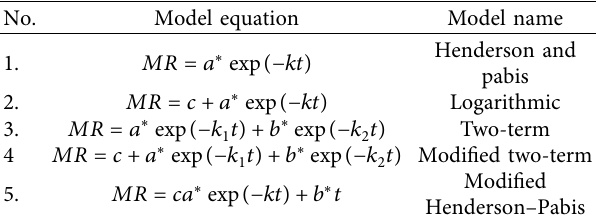
Table 2: Mathematical modeling of food